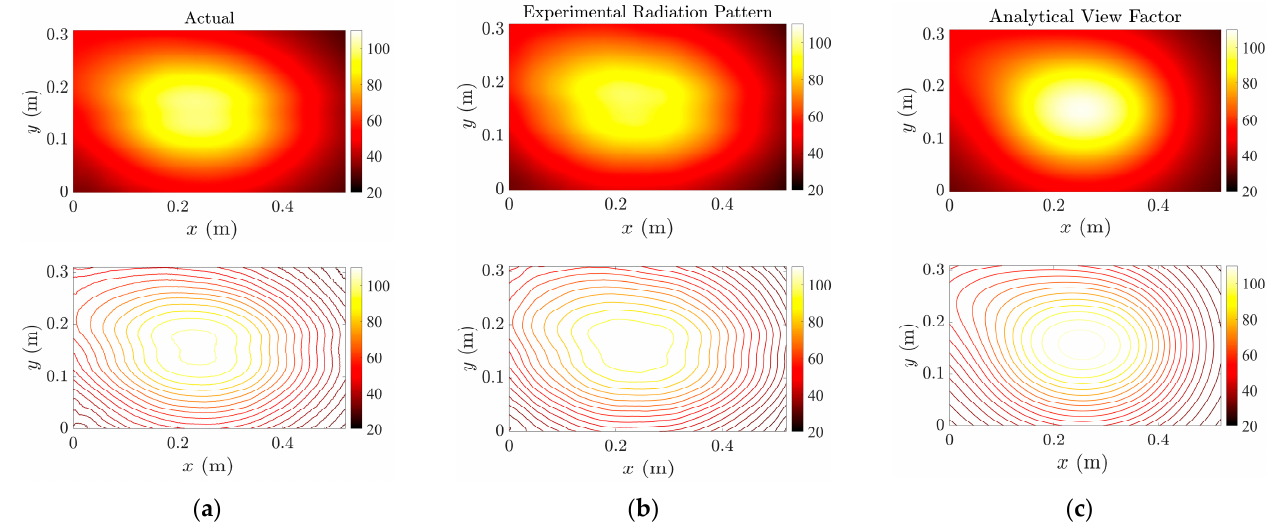
Figure 12. Temperature distribution on the sheet ( a ) laboratory-scale setup; ( b ) designed model based on experimental radiation pattern; ( c ) designed model based on analytical view factors.